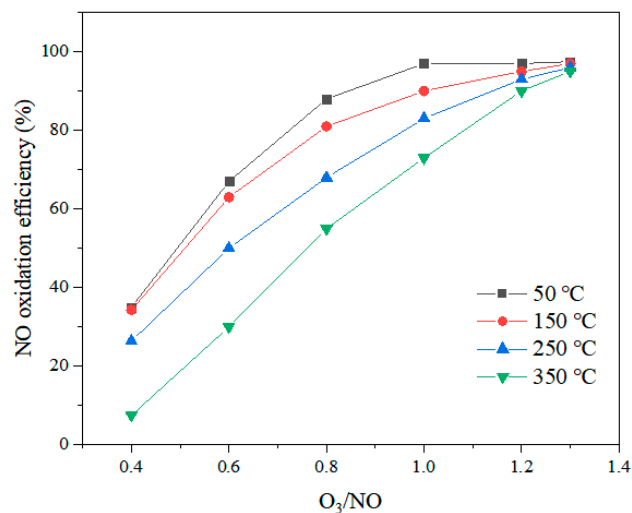
Figure 2. The efficiencies of NO oxidation under different inlet flue gas temperatures and O 3 dosages. The efficiencies of NO oxidation under different inlet flue gas temperatures can be seen in Figure 2. When the NO inlet concentration is 200 ppm, and inlet flue gas temperatures is 50 to 150 ◦ C, the NO oxidation efficiencies have no significant difference; the average efficiencies of the oxidation of NO are above 87% when the molar ratio of O 3 and initial concentration of NO is